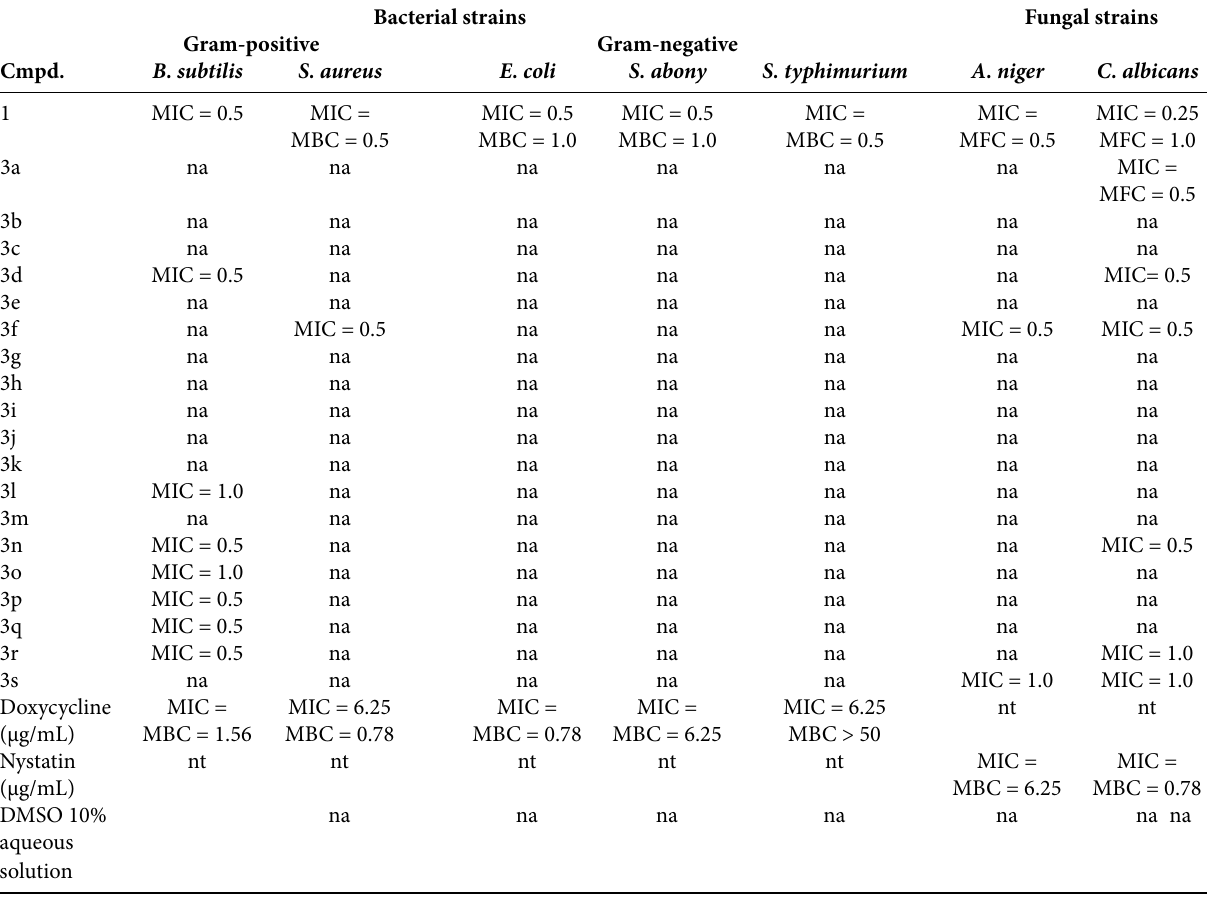
Table 2. The minimal inhibitory (MIC) and minimal bactericidal/fungicidal (MBC/MFC) concentrations (mg/mL) of the eugenol ( 1 ) and the synthetized eugenyl esters 3a – s . MIC and MBC/MFC determinations were carried out in triplicate and consistent values were obtained for each microorganism tested. Bacterial strains Fungal strains Gram-positive Gram-negative